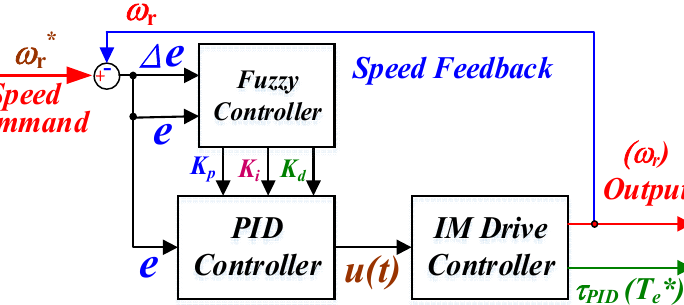
Figure 4. Block diagram of a fuzzy PID controller.